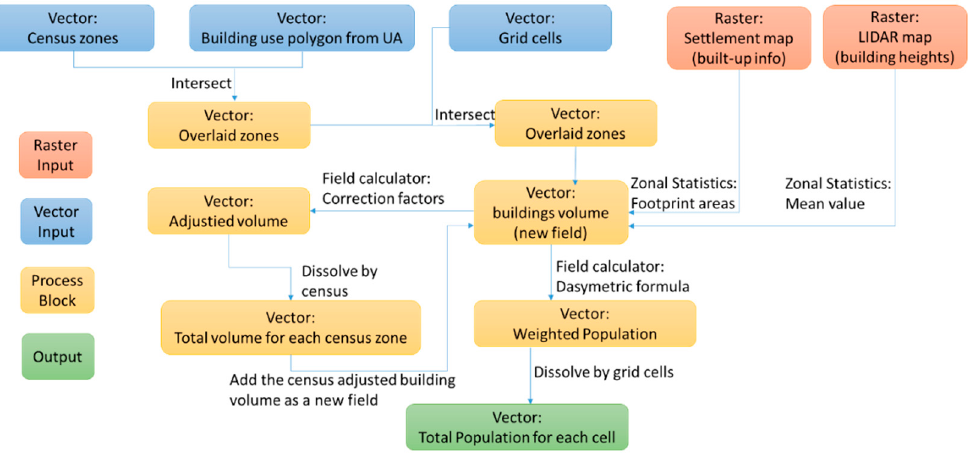
Figure 5. Dasymetric 2.0 version.